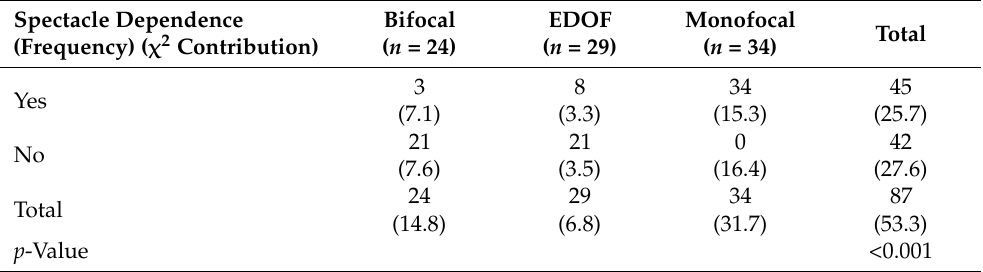
Table 7. Data obtained using the questionnaire subscales to evaluate the levels of postoperative optical quality with respect to spectacle dependence among